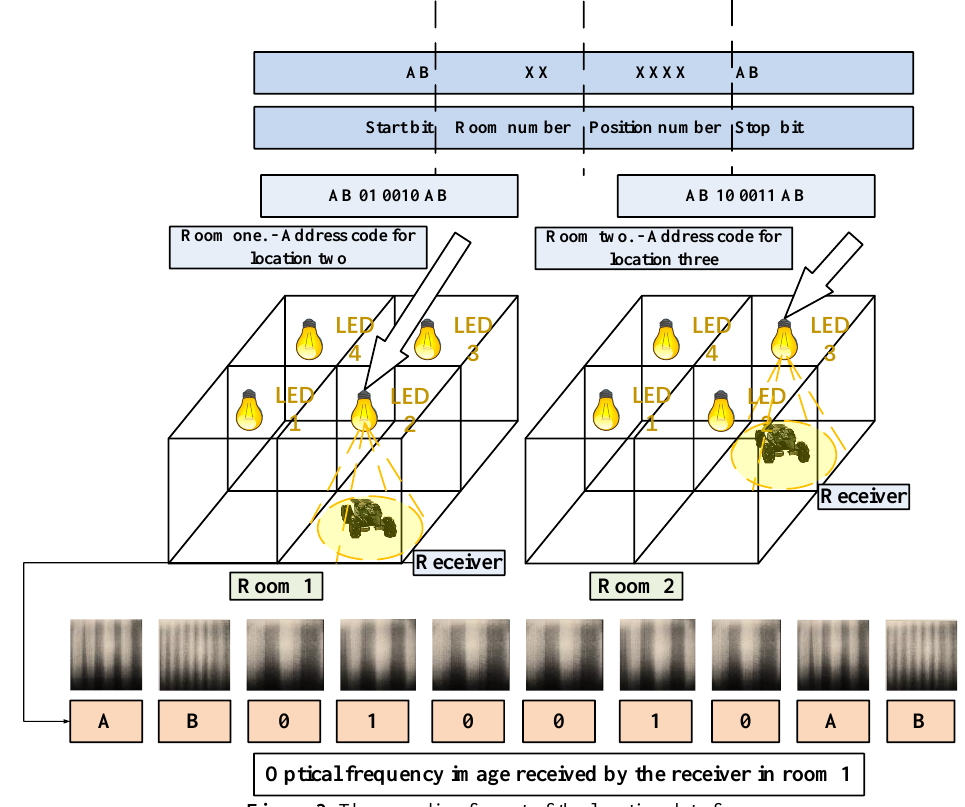
Figure 3 . The encoding format of the location data